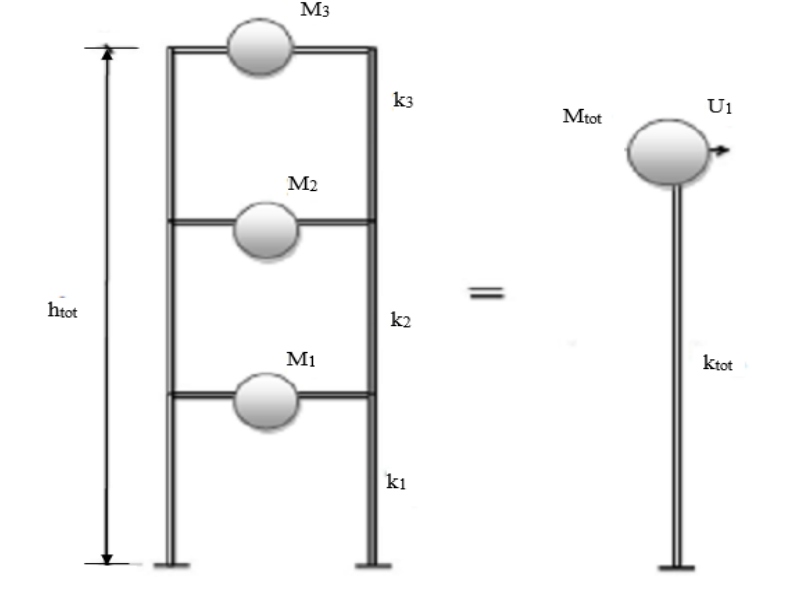
Fig. 1. Equivalent Single Degree of Freedom Frame